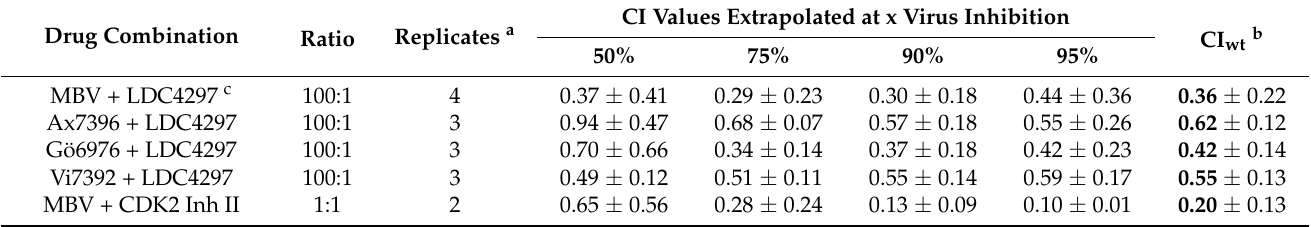
Table 5. Combinatorial anti-HCMV drug assessment using the Loewe additivity fixed-dose assay.